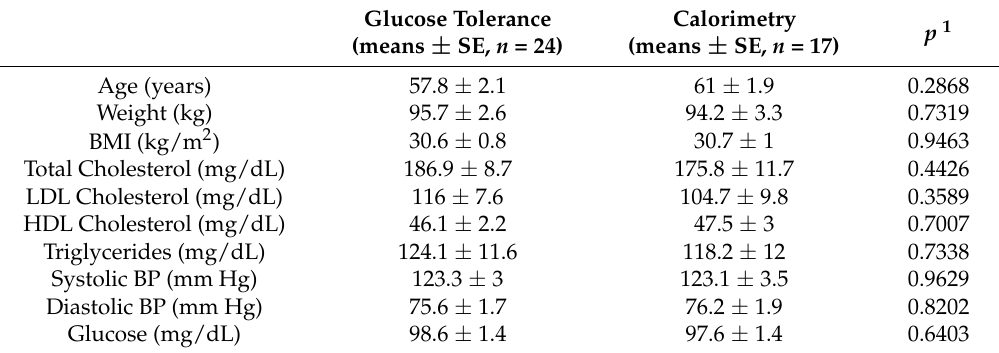
Table 3. Baseline subject characteristics reported for each